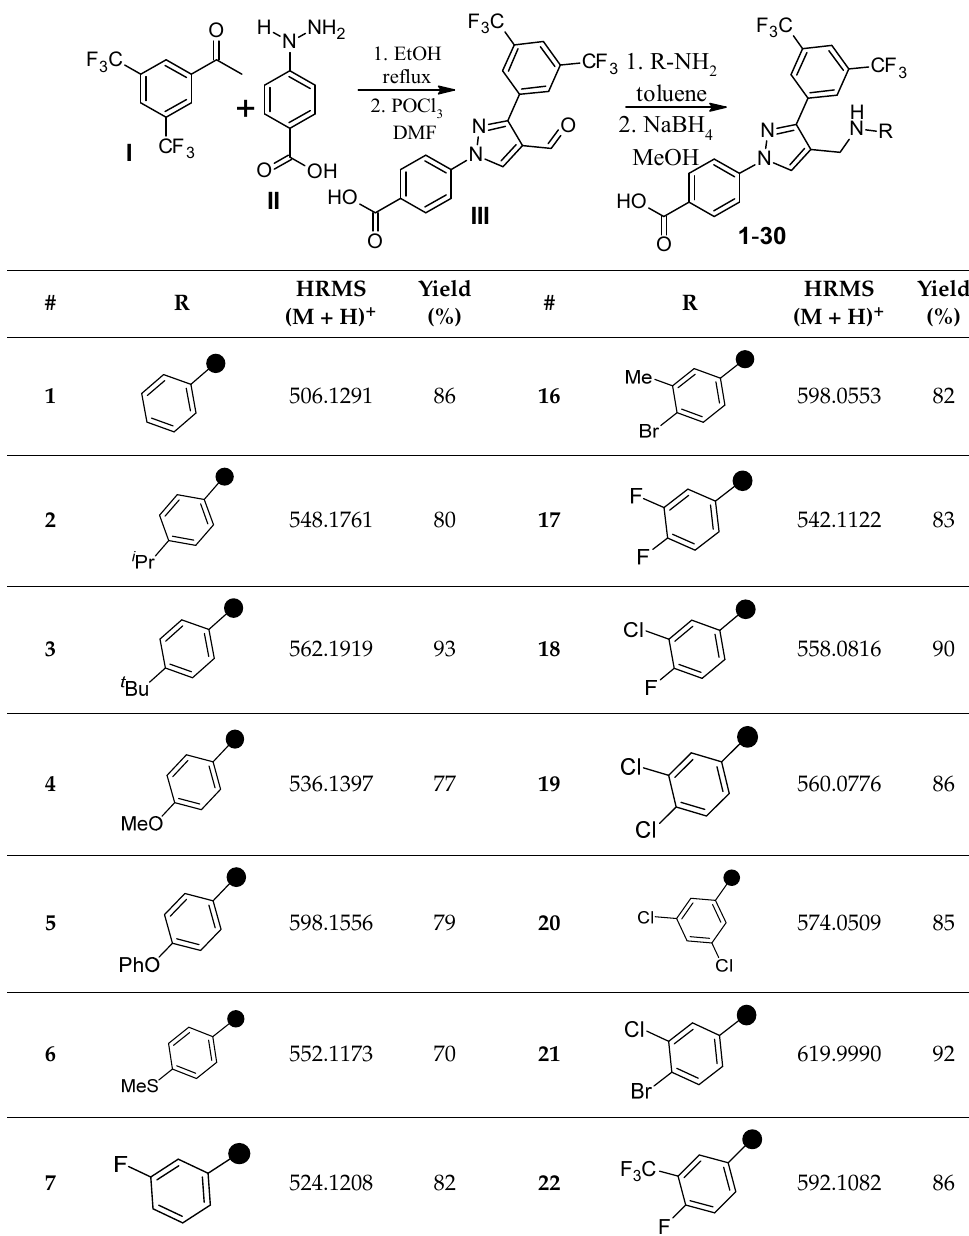
Table 1. Synthesis of 3,5-bis(trifluoromethylphenyl)-derived pyrazole anilines. F 3 C CF 3 NN O NN O